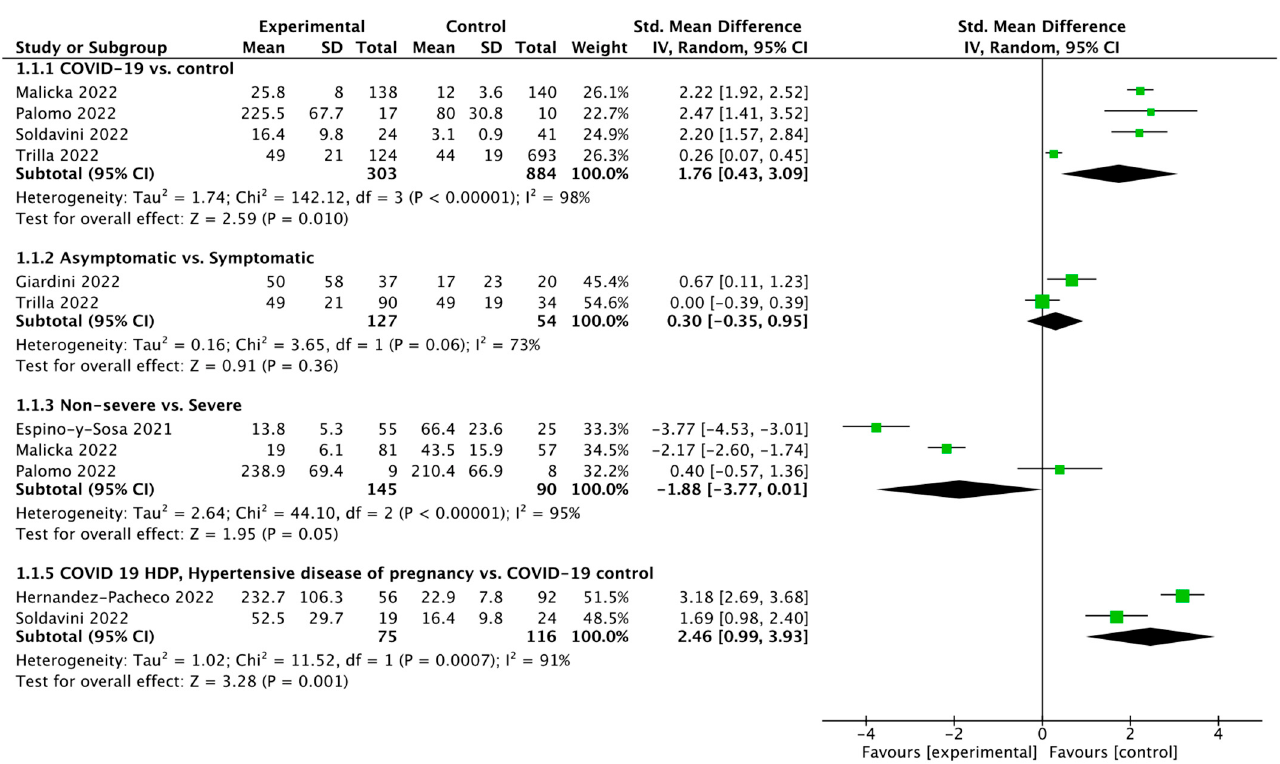
Figure 2. Forest plot of sFlt-1/PlGF ratio in different patients’ groups. The center of each square represents the standard mean differences (SMD) for individual trials, and the corresponding horizontal line stands for a 95% confidence interval (CI). The diamonds represent pooled results